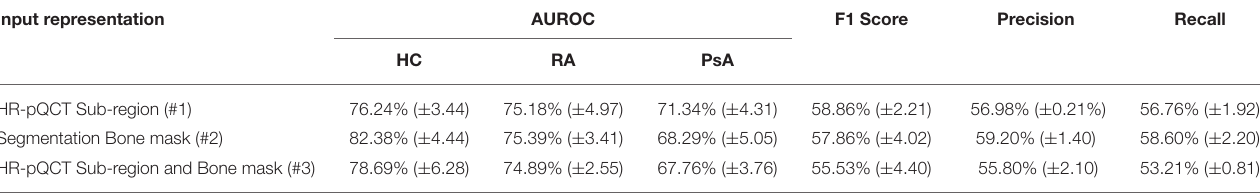
TABLE 2 | Classification results of the CSAE neural network for different input representations visualized in Supplementary Figure 1